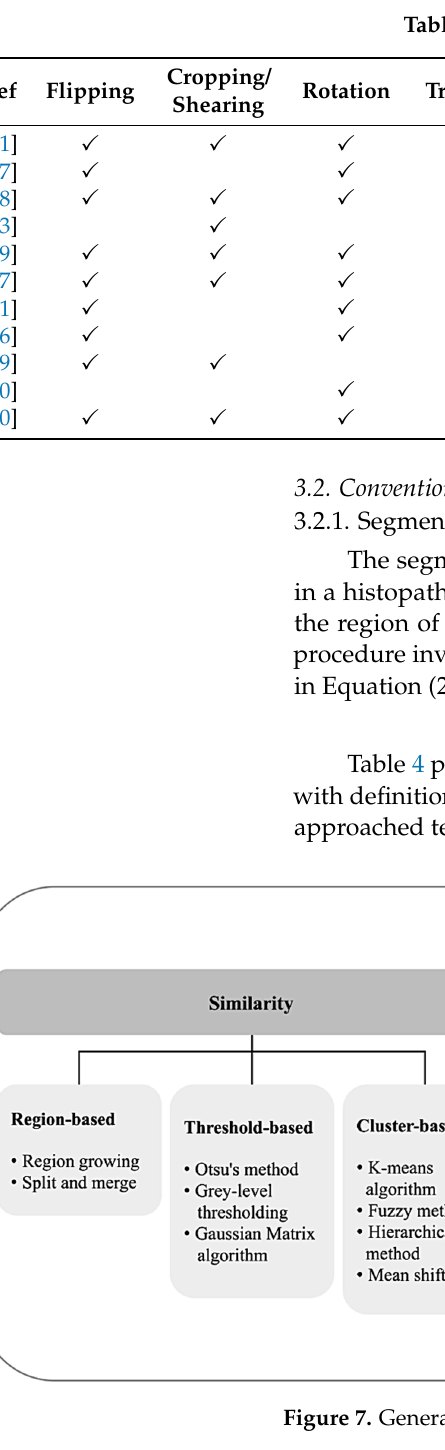
Figure 7. General view of segmentation approaches and techniques.